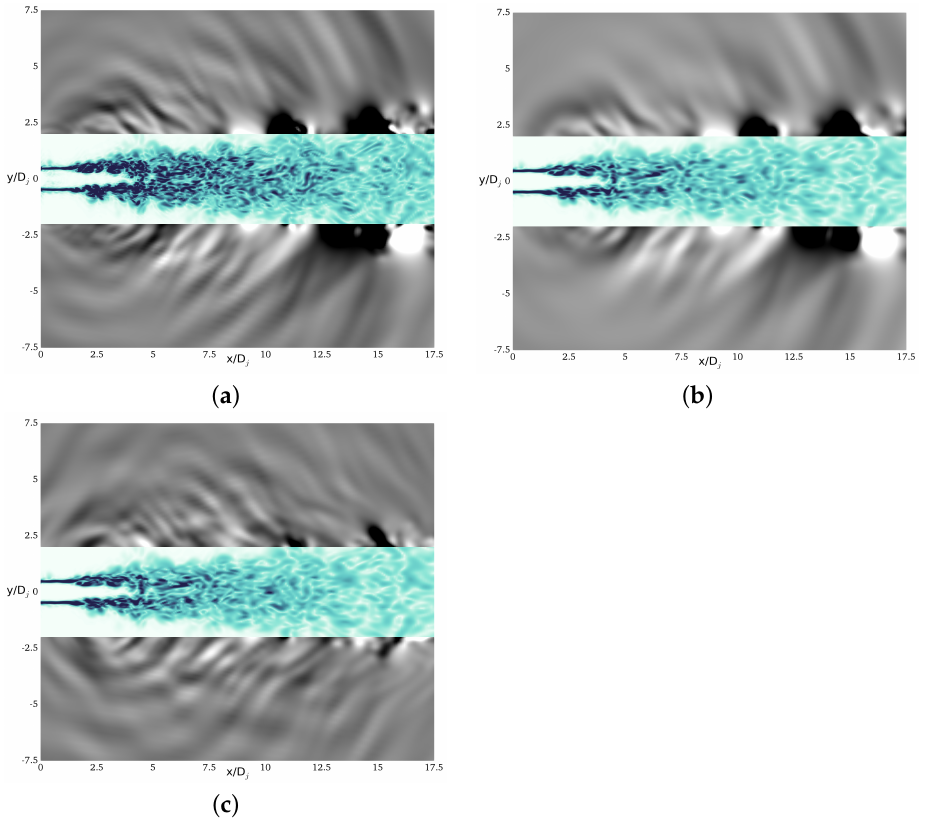
Figure 10. Contours of Vorticity in the Shear Layer and Pressure in Near-Field for LES, CLES, and CLST. Vorticy contours levels range from 0 to 4 ω D j / a ∞ and pressure contours range from − 0.0015 to 0.0015 p / ρ ∞ a 2 ∞ : ( a ) LES. ( b ) CLES. ( c )